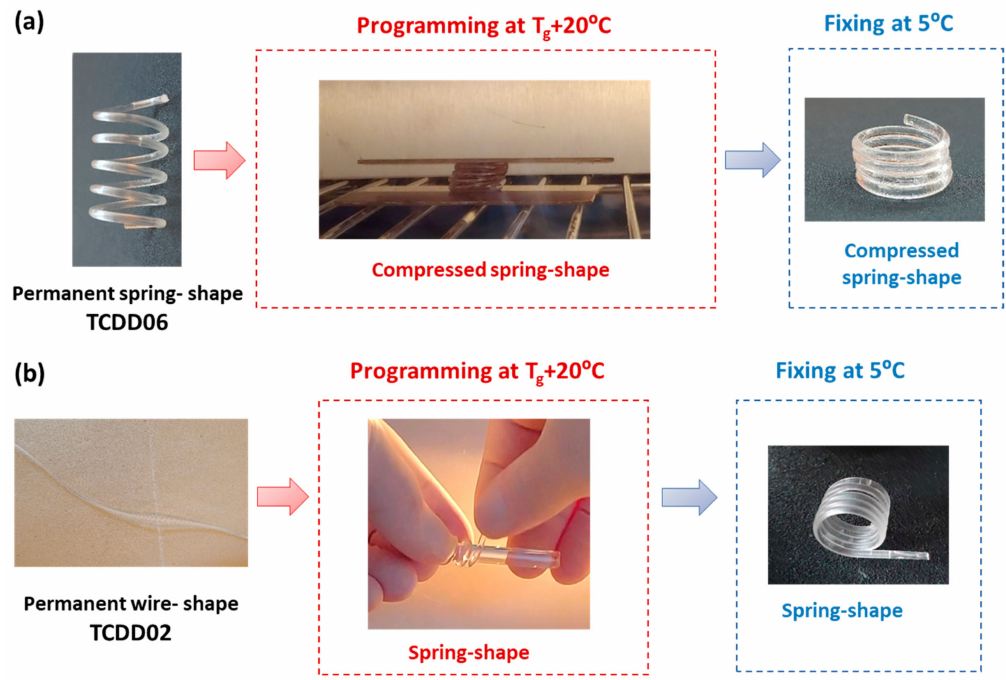
Figure 11. Programming of TCDDA06 and TCDDA02 samples: ( a ) TCDDA06 with a permanent spring shape is programmed in the form of a compressed spring. ( b ) TCDDA02 with a permanent shape of wire is rolled up around a cylindrical rod and a temporary spring shape is